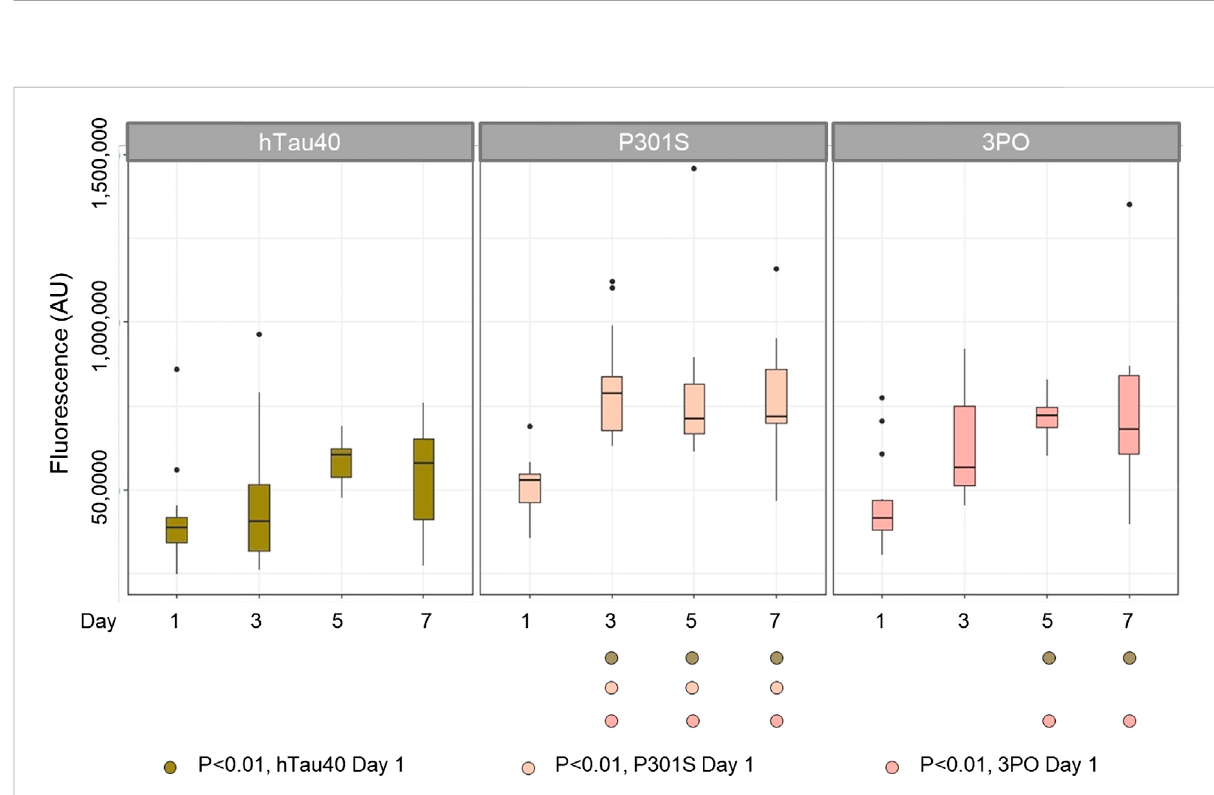
FIGURE 3 TauGFP is stable and accumulates in an age-dependent manner in neurons and axons. Day 1 nematodes strains have similar GFP intensity suggesting that the tau integrants have equivalent levels of expression. By day 3 (P301S) and day 5 (3PO) fl uorescence was signi fi cantly increased, respectively, suggesting a signi fi cant buildup of tau while hTau40 remained statistically constant during the selected time points. ANOVA (Day*Variant) with Tukey post-hoc comparison. N = 12 –